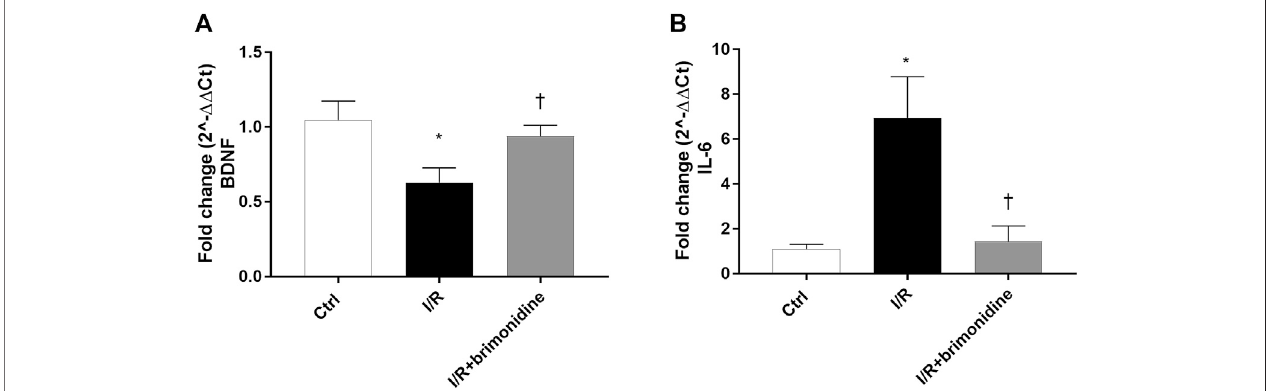
FIGURE2| BDNFandIL-6mRNAexpressioninmiceretina.BrimonidinetreatmentmaintainedBDNF (A) mRNAlevelsclosetocontrolgroup,incomparisontoI/R injured mice. Furthermore, brimonidine reverted the up-regulation of IL-6 (B) elicited by I/R injury. The mRNA levels were evaluated by RT-PCR; values represent the mRNA fold changesrelativeto 18 Sused ashousekeeping gene. Values arereported asa mean ± SD ( n (cid:2) 5). One-way ANOVA analysis wasperformed followed by the Tukey post-hoc test. * p < 0.05 vs. Ctrl; † p < 0.05 vs. I/R.